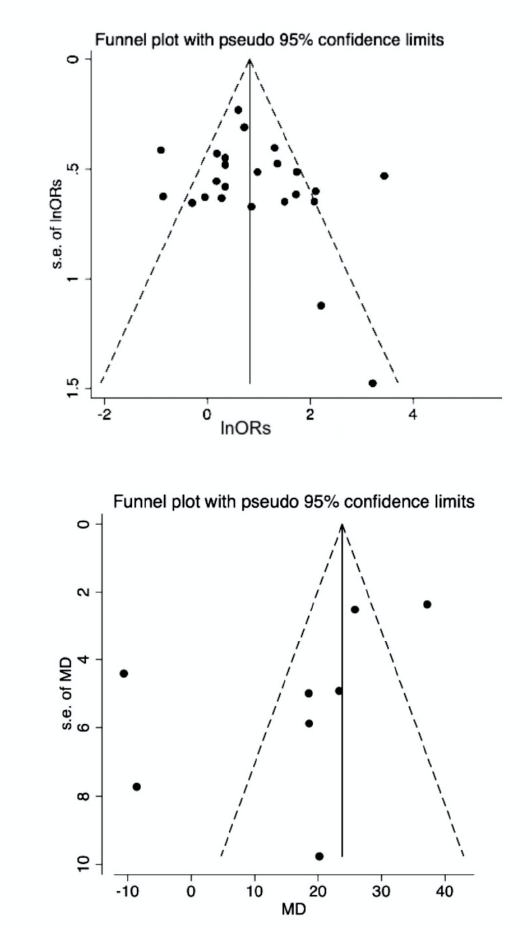
Figure 3. Funnel plot for both study models . Despite the non-significant Egger and Begg tests, there is a visual asymmetry in the funnel plots, indicative of a degree of publication bias. MD; weighted mean differences, OR; odds ratio, SE; standard error.